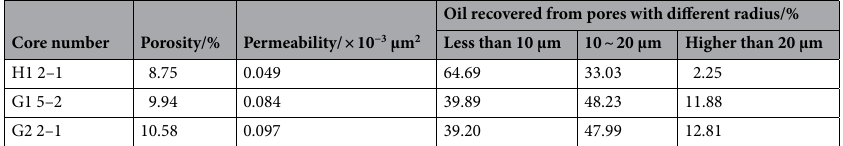
Table 2. Relative recovery of different pores of Chang 7